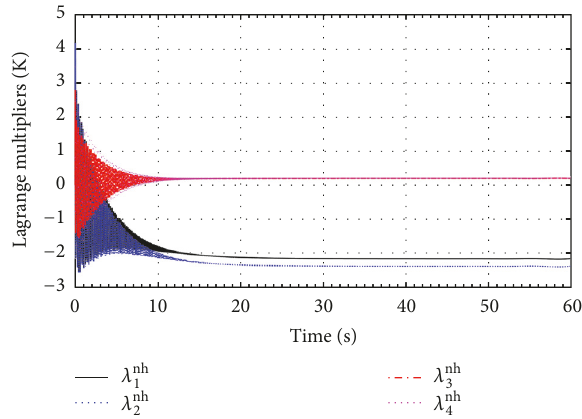
Figure 10: Lagrange multipliers of nonholonomic constraints.